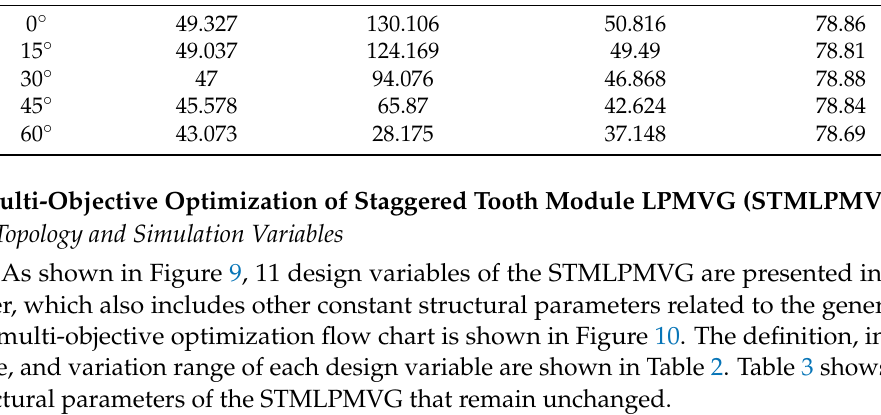
Figure 8. Staggered tooth bilateral linear permanent magnet vernier generator.